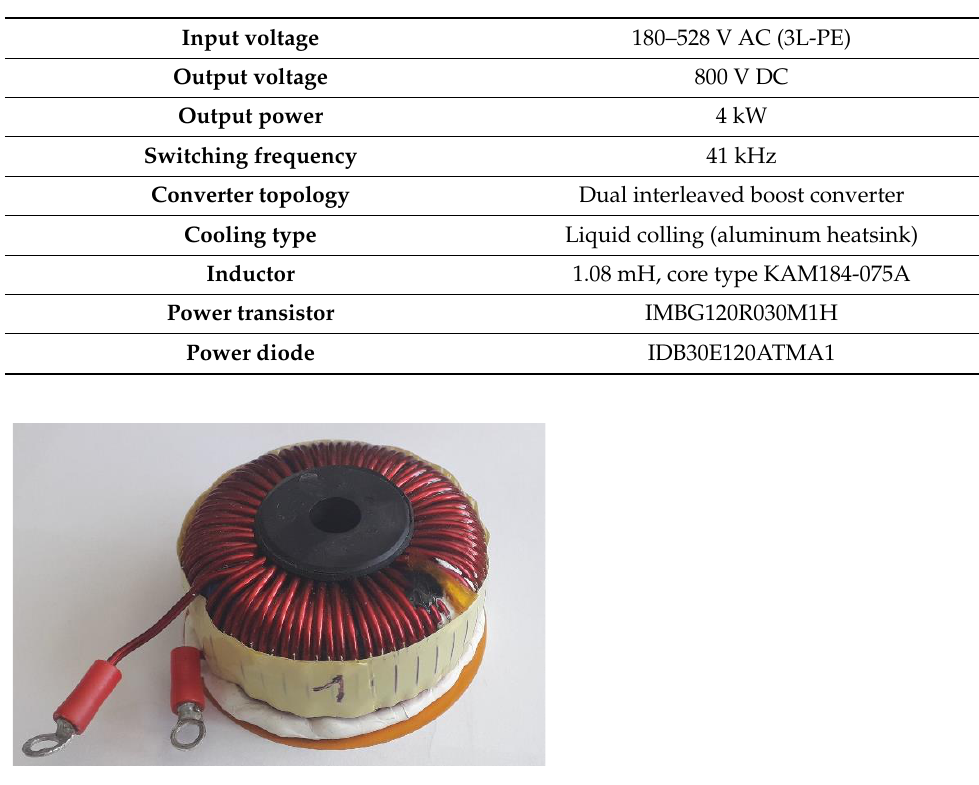
Figure 19. Original alloy core inductor used within optimized PFC converter used for referenced measurements.